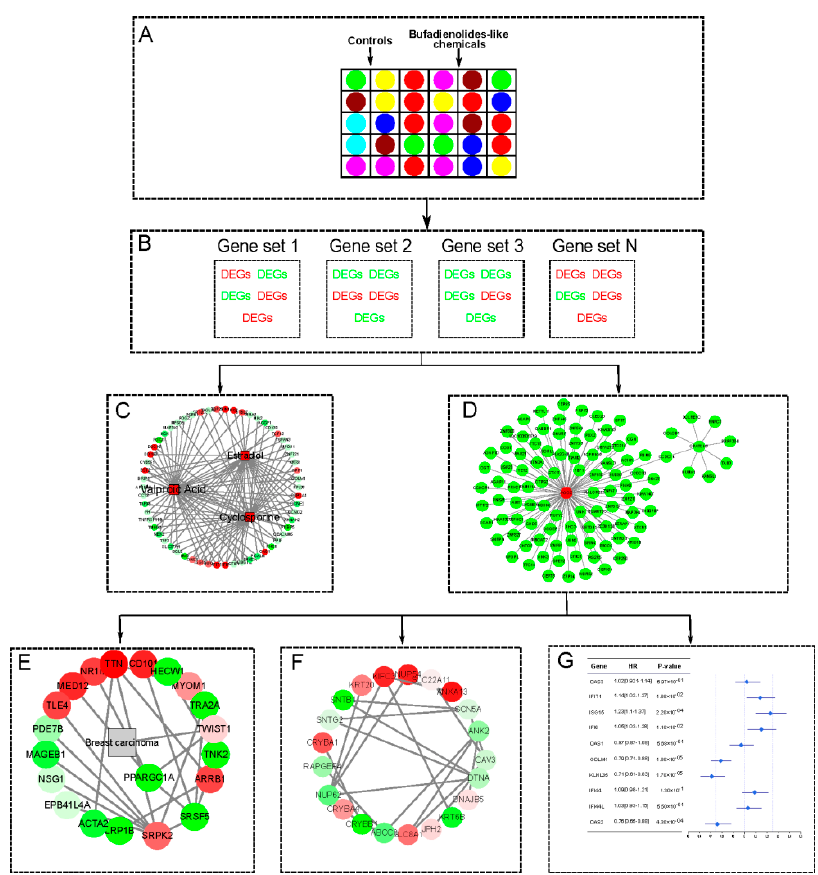
Figure 2. The workflow to study the potential mechanism of bufadienolides-like chemicals on breast cancer via bioinformatics analysis. ( A ) The experimental design and basic information of this analysis. ( B ) The DEGs’(Differentially expressed genes) identification with the GSVA (Gene set variation analysis) algorithm [15]. ( C ) Similar small-molecule detection with the Comparative Toxicogenomics Database (CTD) [16] and connectivity map (CMAP2) [17,18] database. ( D ) The tissue-specific